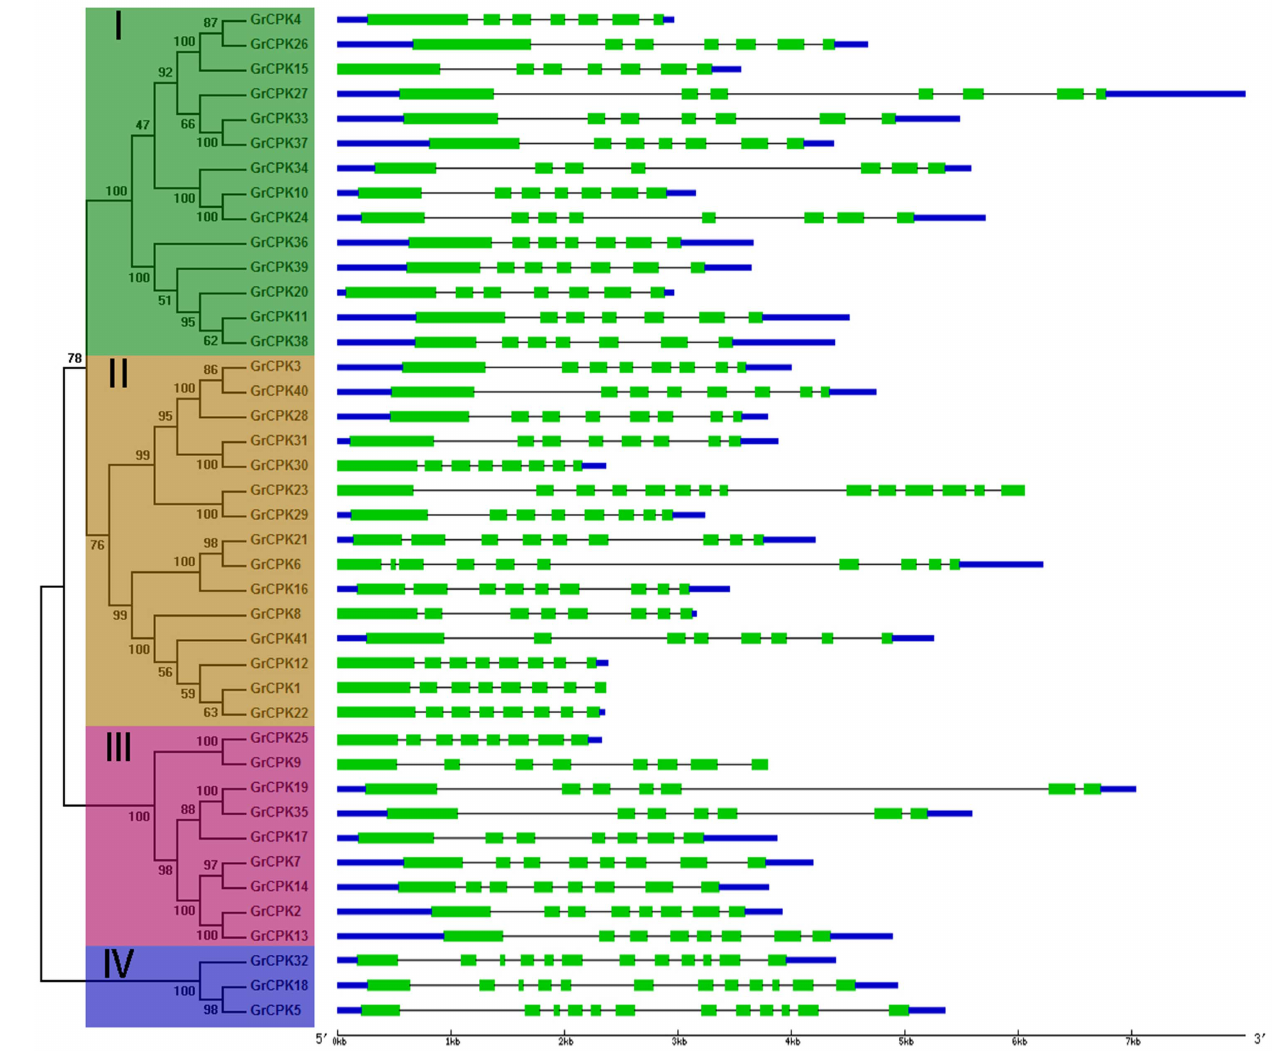
Figure 2. Phylogenetic relationship and gene structure of CDPK genes from G.raimondii . Four subfamilies labeled as I, II, III, and IV are marked with different color backgrounds. Exons are represented by green boxes and introns by black lines. The untranslated regions (UTRs) are indicated by thick blue lines.